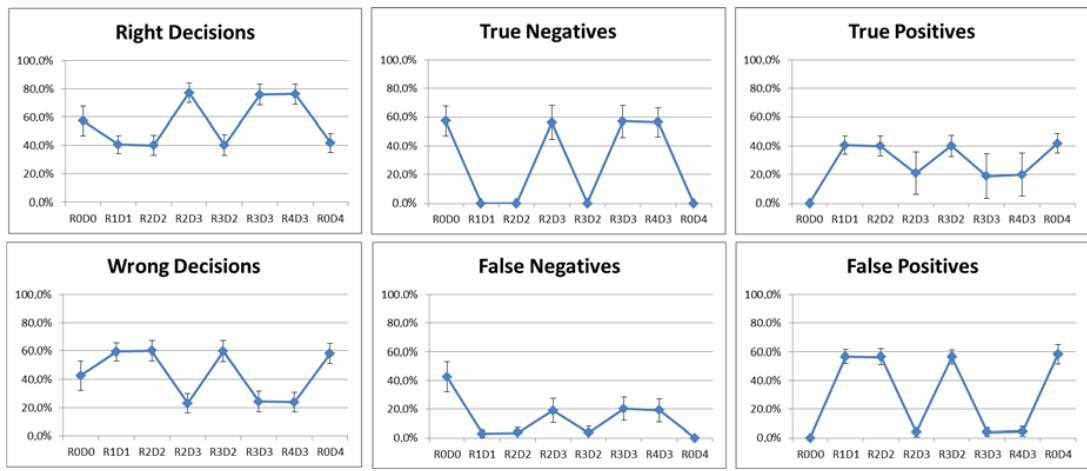
Figure 10. Inconsistency attack for Restricted Scenario experiments.